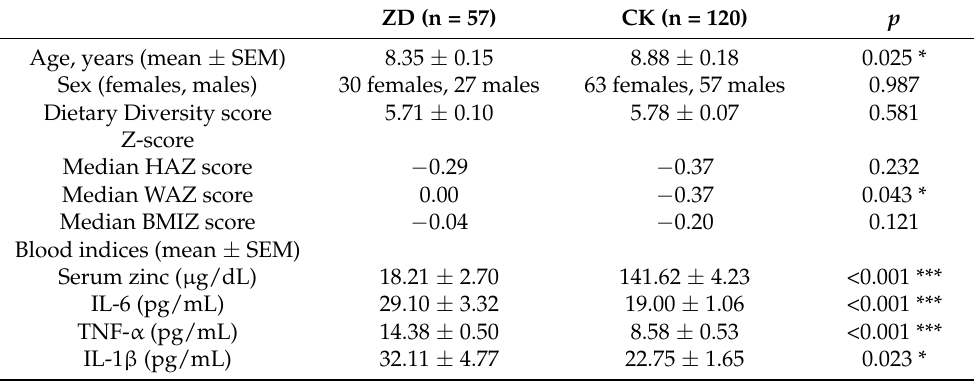
Table 1. Characteristics of zinc-deficient and control children (n = 177).